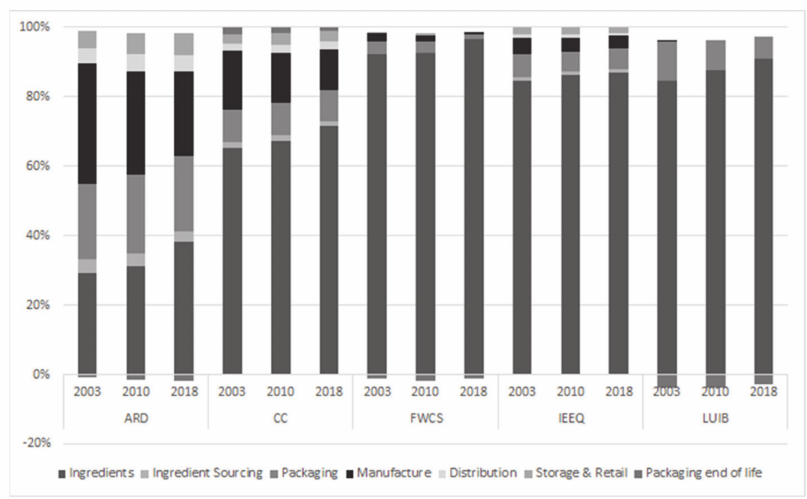
Figure 5. Contribution of each life cycle assessment (LCA) stage on the overall environmental indicator (data for the average product, n = 3); CC: climate change; ARD: abiotic resource depletion; LUIB: land use impact on biodiversity; IEEQ: impact on ecosphere / ecosystems quality; FWCS: freshwater consumption scarcity.